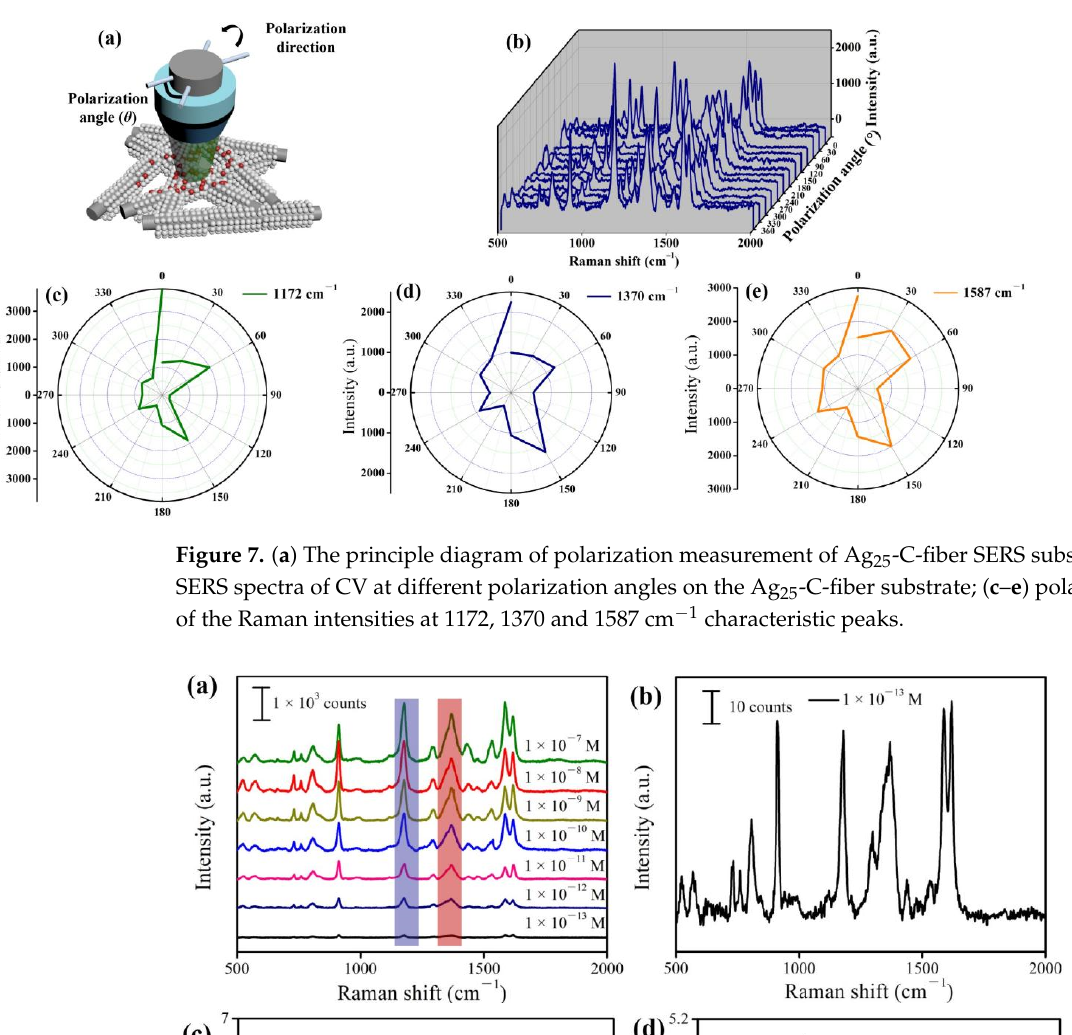
Table 2. LOD for CV on different SERS substrates with different nanostructures reported previously.